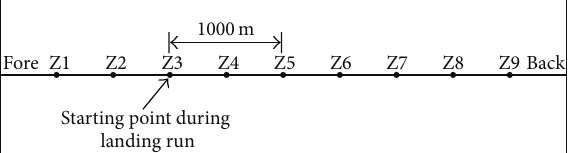
Figure 3: The plan view of VLFS during landing or